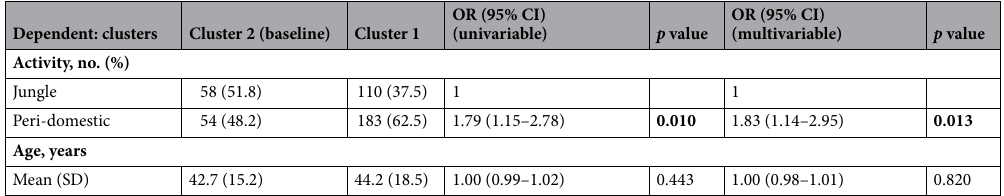
Dependent: clusters